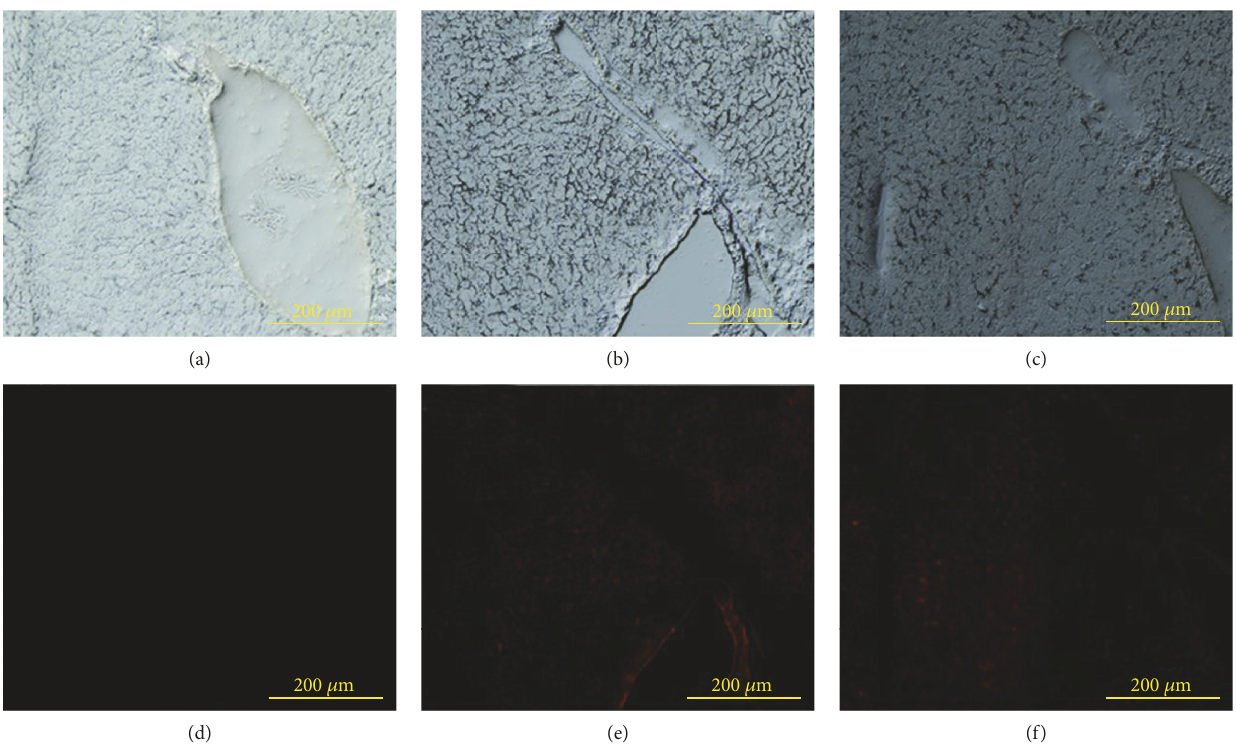
Figure 2: Engraftment of PKH-stained rBM-MSCs and rBM-MSC-DSCs in DMN -injured rat livers. Nontransplanted liver from DMN-damaged rats was used as the control (a and d). rBM-MSCs (b and e) and rBM-MSC-DSCs (c and f) were transplanted into DMN- damaged rats, and 4 weeks later liver sections were observed using fl uorescence microscopy. The upper panel (a, b, and c) and lower panel (d, e, and f) picture are bright- fi eld and fl uorescence images, respectively, with PKH-stained cells within the tissue fl uorescing red. Original magni fi cation, 200x.